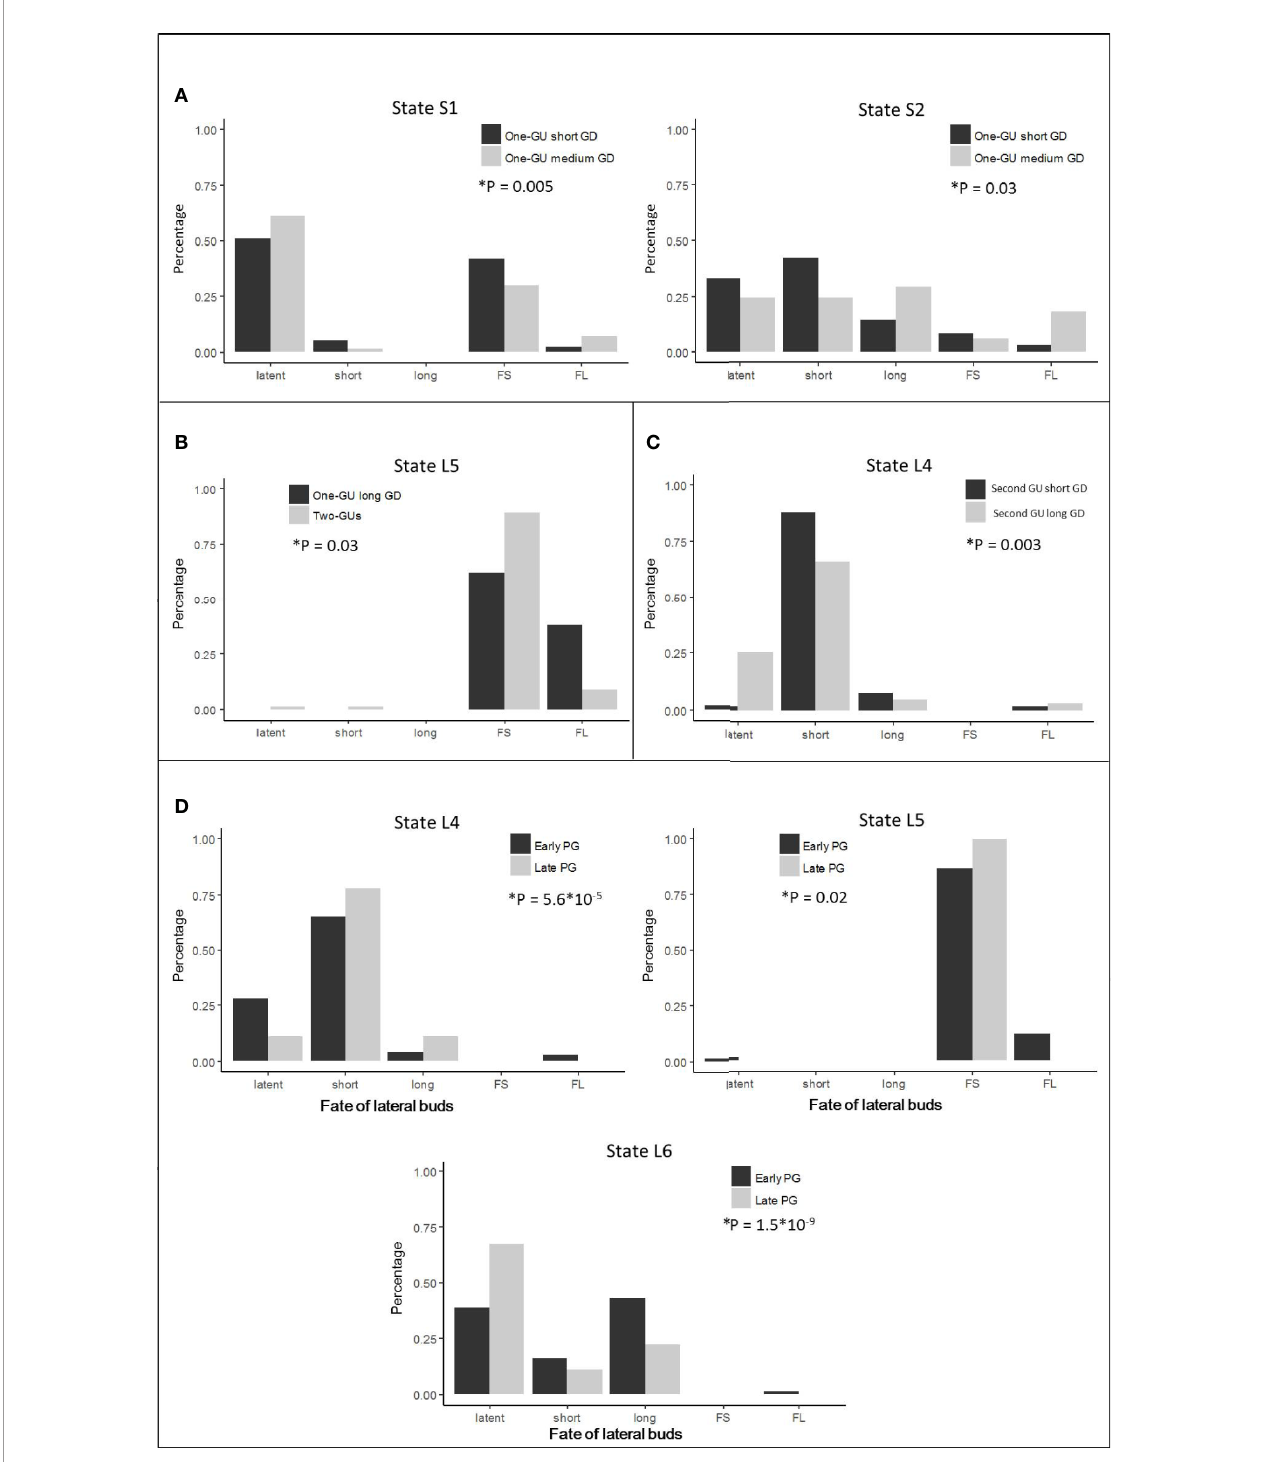
FIGURE 6 | The distribution of lateral types per state, extracted from the most probable state sequences estimated by the general hidden semi-Markov models for different parent shoot categories. The lateral types are latent buds (latent), short shoots (short), long shoots (long), fl oral units with a short bourse-shoot (FS), and fl oral units with a long bourse-shoot (FL). The distributions are compared for each state with more than one lateral type between (A) one-GU shoots with short versus medium growth duration (GD), (B) one-GU shoots with long GD versus two-GUs shoots, (C) second GU of two-GU shoots with short versus long GD (D) second GU long GD with an early versus a late growth period (GP). The comparison was performed using Fisher ’ s exact tests. The test is signi fi cant (*) when P